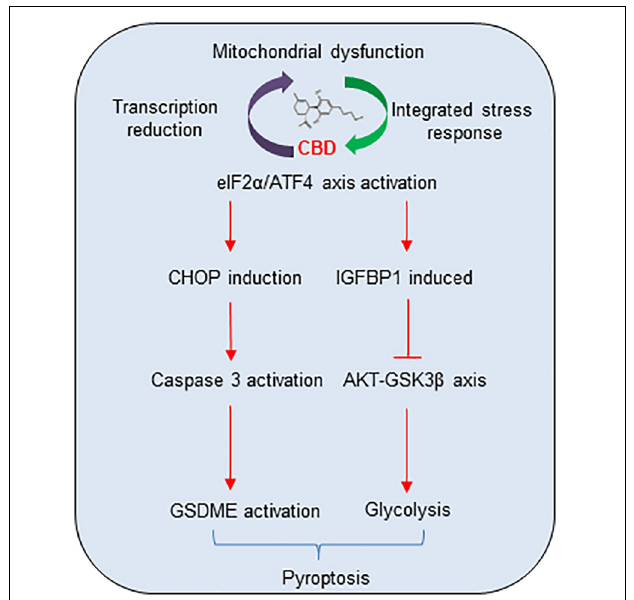
FIGURE 7 | The proposal mechanistic model of CBD depresses HCC through modulating ISR-dependent pyroptosis and IGFBP1/AKT axis mediated glycolysis inhibition. CBD triggers accumulation of integrative stress response and mitochondrial stress, which subsequently induces ATF4 and its target genes CHOP and IGFBP1 activation. Then, increased CHOP promotes pro-apoptosis factor of BCL-2 family to trigger caspase-3/GSDME dependent pyroptosis and activates IGFBP1 to depress glycolysis by restraining the AKT/GSK3 β axis.